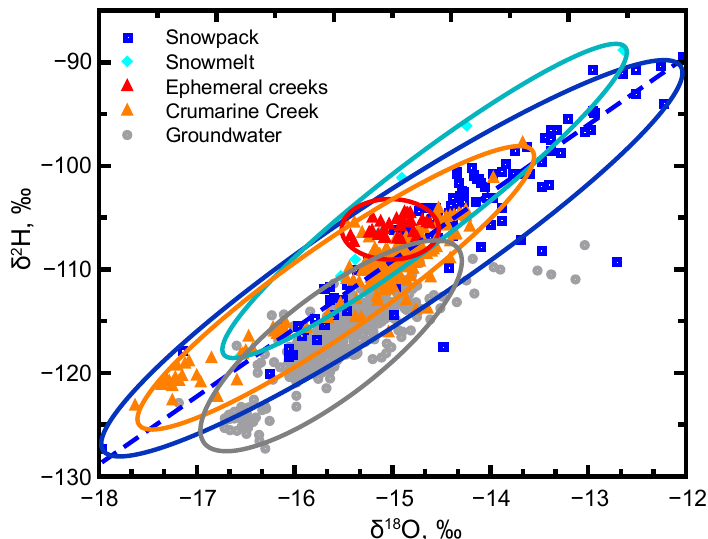
Figure 10. Groupings of δ 2 H and δ 18 O values indicative of the evolution and variability of the isotope signals from snowpack and snowmelt to local surface-water and groundwater systems. Crumarine Creek and groundwater values are from Sanchez-Murillo et al. [63] and Candel et al. [64], respec- tively.